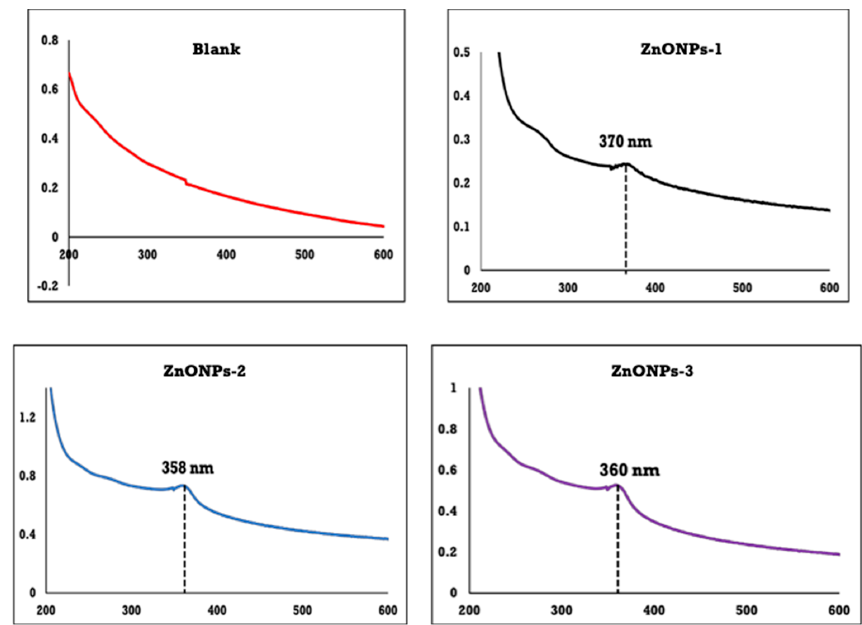
Figure 2. UV-vis of sodium alginate (blanks) and ZnONPs (ZnONPs-1, ZnONPs-2, ZnONPs-3). The sample coded with ZnONPs-1 has an absorption peak at 370 nm, while the graph shows that the absorption peak of ZnONPs-2 was moved to 358 nm with increasing the concentration of zinc acetate to 3 g. On the other hand, the absorption peak of ZnONPs-3 was shifted again to a high wavelength (360 nm) when the zinc acetate concentration was increased to 4.5 g. The band is practically sharp with the second concentration (ZnONPs-2), implying that the size of particles seems to be nearly identical and hence the particle generated with homogeneity characteristics. On the other hand, ZnONPs-1 and ZnONPs-3 have very broad bands, indicating that the produced particles are heterogeneous.